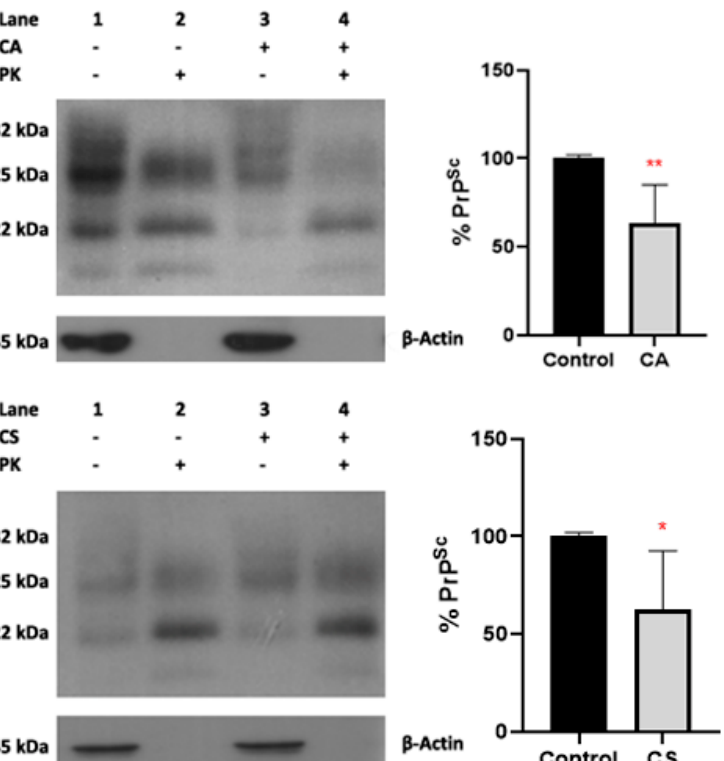
Figure 4. Effect of Carnosic acid (CA) and Carnosol (CS) treatment on PrP Sc levels (in vitro assays). N2a22L cells were incubated with 0.5 × LD 50 of CA and CS for 48 h or left untreated (Control), lysed, and then divided into two different fractions. 0.5 × LD 50 was estimated at 14.84 µ M for CA and 16.53 µ M for CS for N2a58 and at 13.58 µ M CA and 12.85 µ M CS for N2a22L. Fraction lysates were either treated (+) or not (-) with PK, and 50 µ g of PK-untreated or 100 µ g of PK-treated fraction was resolved by SDS-PAGE and immunoblotted with the anti-PrP antibody 6H4 (1:5000) and an anti- β - actin (1:2000) antibody. One representative blot for each compound, along with the densitometric analysis from three independent experiments, are depicted. Data represent means ± SD; stars denote statistical significance (unpaired, one-tailed, T -test); *: p value < 0.05, **: p value < 0.01. CA: dark grey, CS: light grey, Control: black.